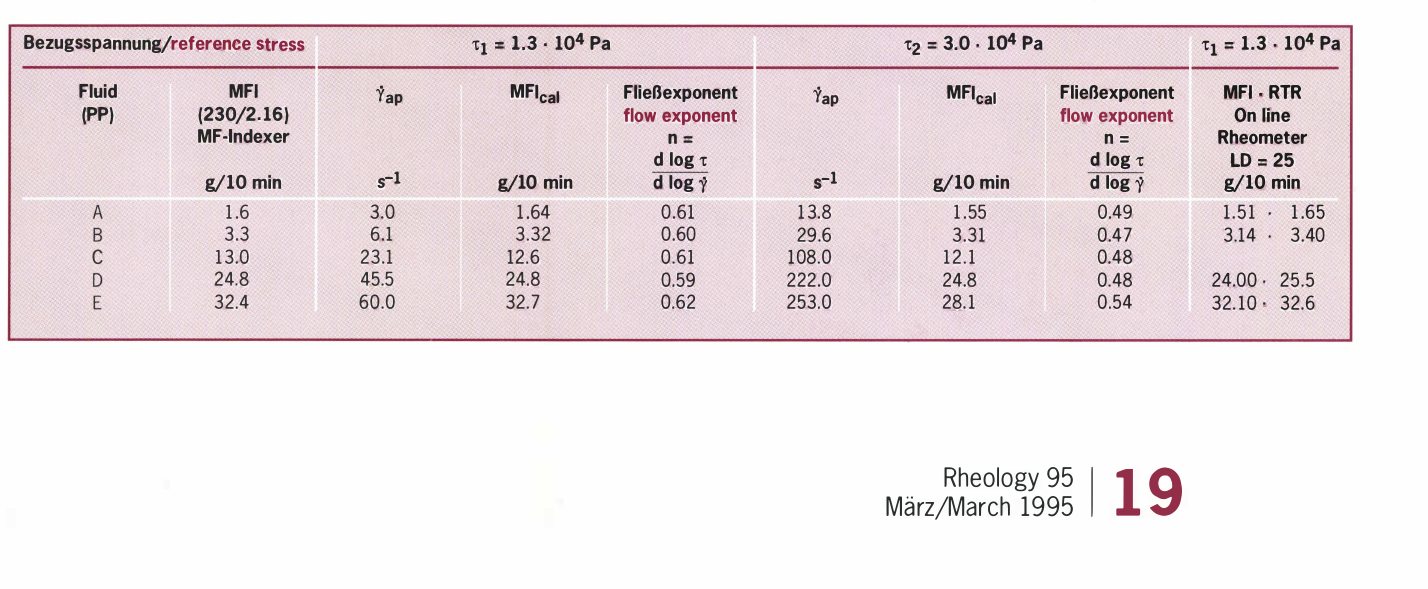
Table 1: Melt index values MFI (230/216) of polypropylene melt, measured with the melt index tester and derived from laboratory and on-line